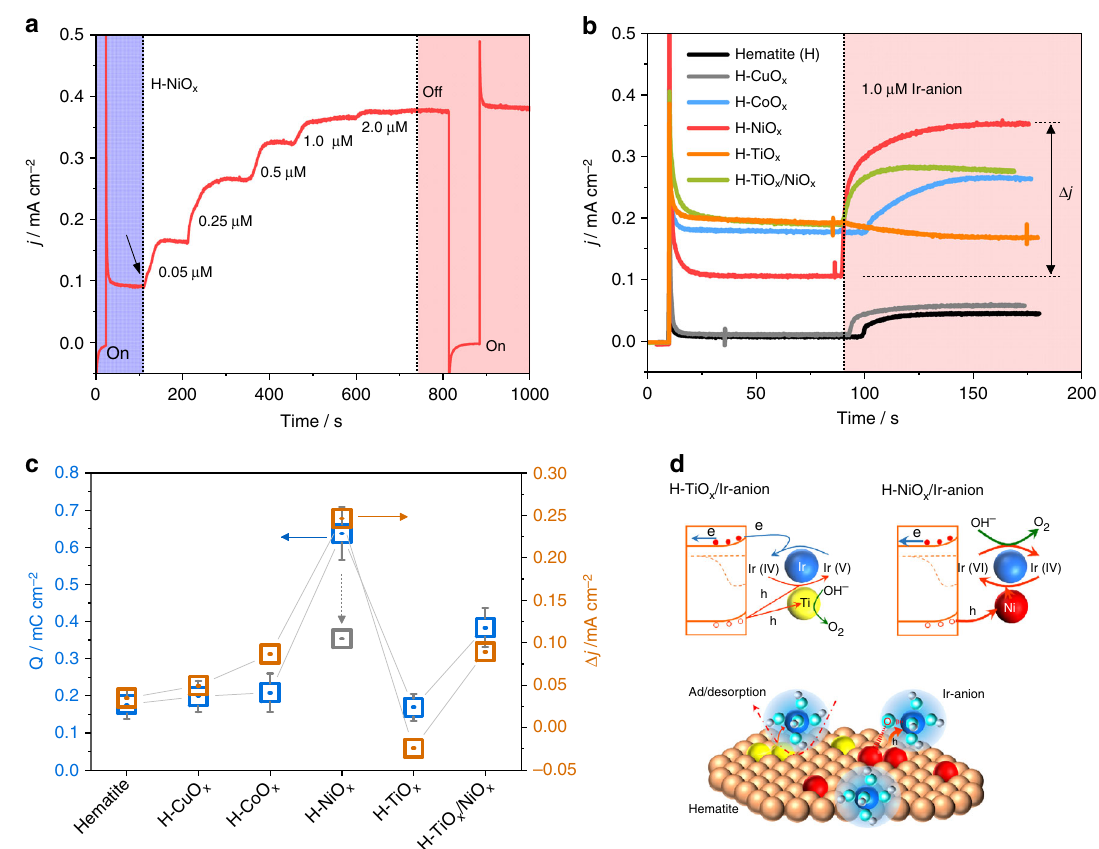
Fig. 2 Photoelectrochemical tests. a OER activity of the H-NiO x /Ir-anion with a stepwise increase of Ir-anion solution concentration. b MO x -modi fi ed hematite exhibits signi fi cant activity difference ( Δ j ) upon dripping the Ir-anion-containing solution. c The correlation between the hole accumulation capacity of H-MO x before the addition of Ir-anion (Supplementary Fig. 9) and the activity difference Δ j after the introduction of 1.0 µ M Ir-anion relative to the Ir-anion-free electrolytes. The gray arrow shows the decreased capacity of H-NiO x from 0.64 to 0.35 mC cm − 2 (gray square) after the introduction of Ir-anion to the electrolyte. Error bars represent the standard deviation. d Proposed reaction paths explaining the different roles of TiO x and NiO x for